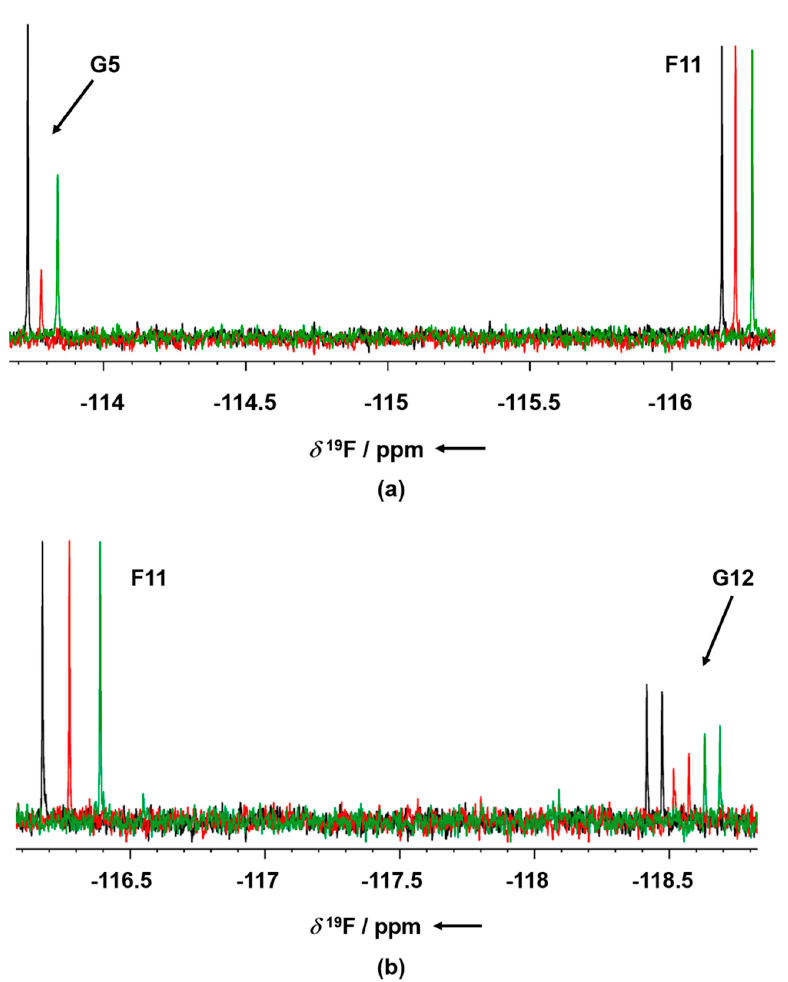
Figure 2. 19 F T 2 filter NMR spectra of G5 ( a ) and G12 ( b ) in absence of GSK-3 β (blue), in presence of GSK-3 β and 1 mM AMP-PNP (red) and in the presence of GSK-3 β and 3 mM AMP-PNP (green). F1 compound signal is used as the negative internal control. Binding compounds G5 and G12 show a strong line broadening of their NMR signals in the presence of the protein (arrow), whereas the NMR signal of the negative control (non-binder) remains unaltered in absence and in presence of protein. The 19 F T 2 filter spectrum of the two compounds was not affected by the presence of either 1 or 3 mM AMP-PNP.